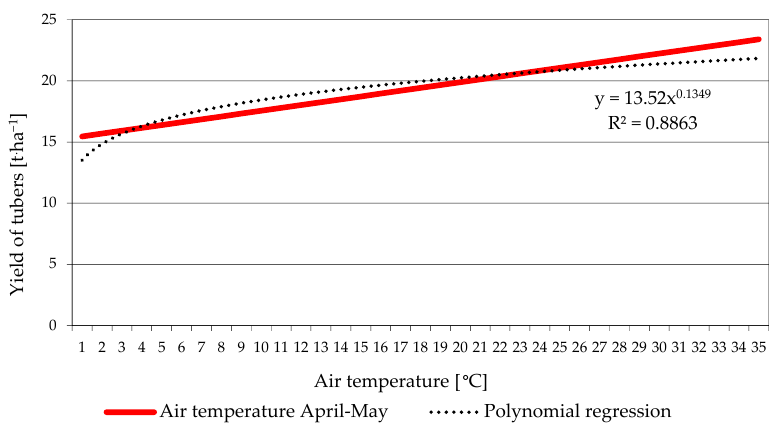
Figure 5. Partial dependence of tuber yield on air temperature in the April–May period.